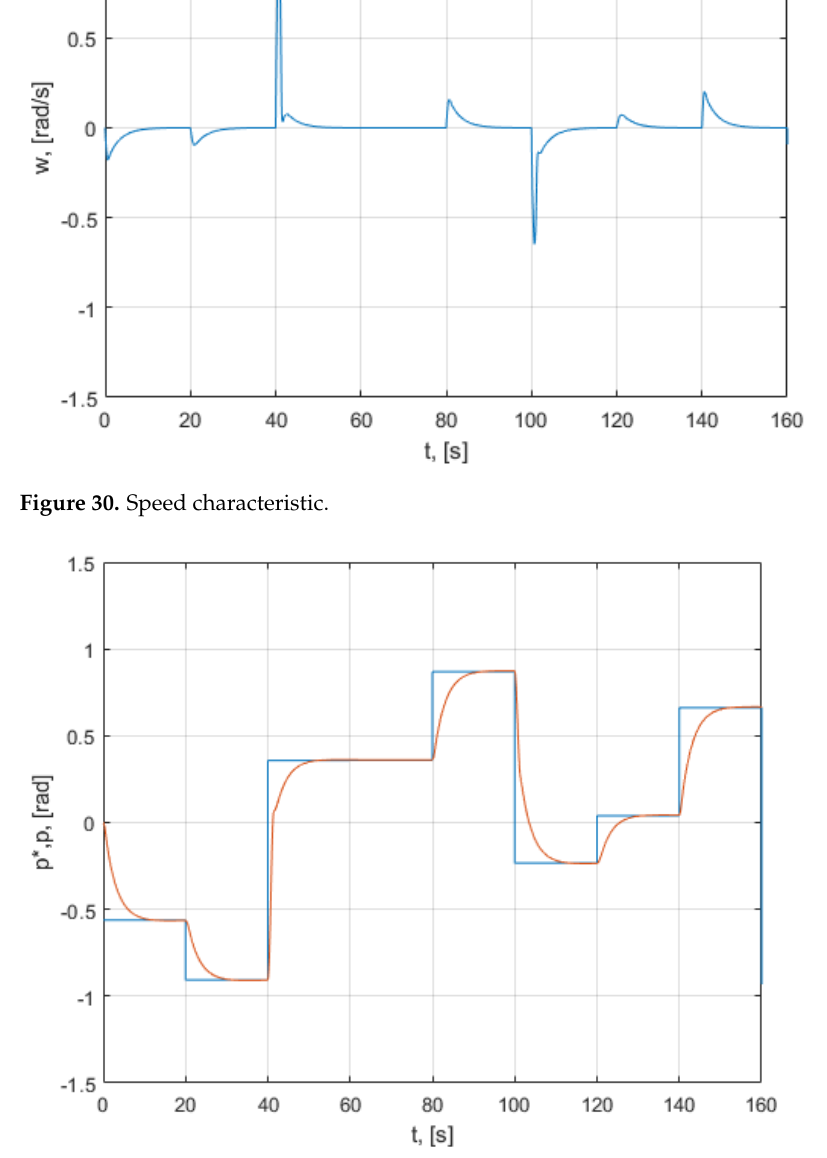
Figure 31. Position reference — blue, measured position — red.